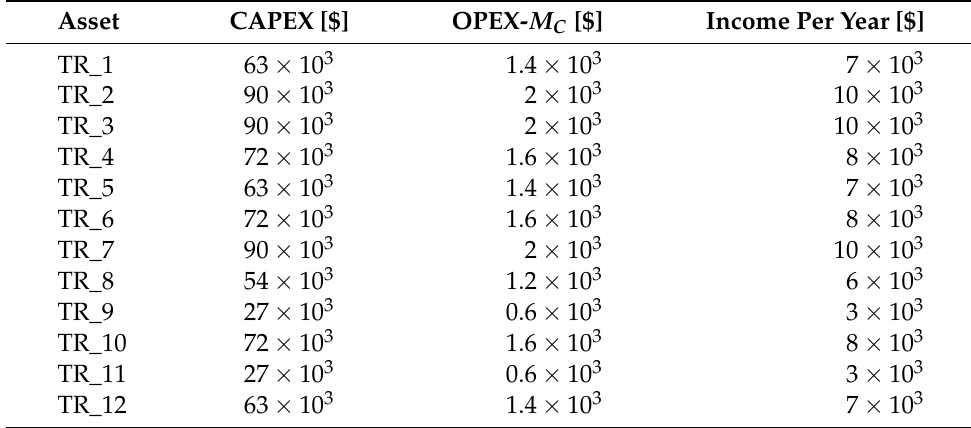
Table 5. Assumed financial parameters for the asset fleet.